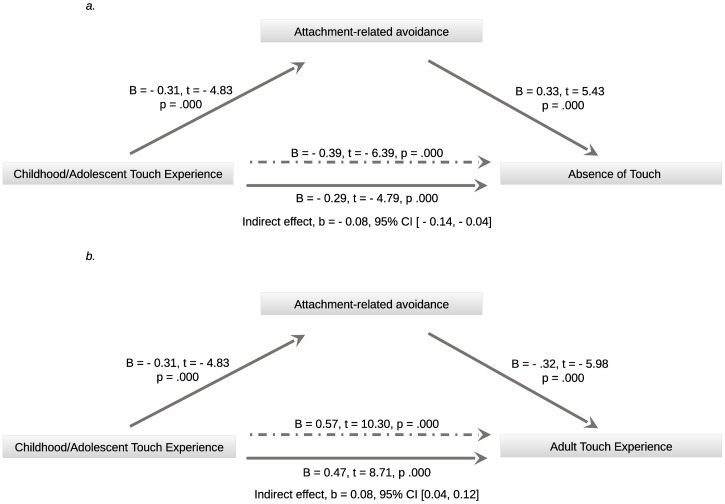
Mediation models.a. Model of childhood/adolescent touch as predictor of current touch exposure, mediated by attachment-related avoidance. b. Model of childhood/adolescent touch as predictor of adult touch experience, mediated by attachment-related avoidance. Dotted arrows represent total effect of predictor on outcome when other variables are not included in the model. Confidence intervals reported for the indirect effect are bootstrapped based on 5000 samples.